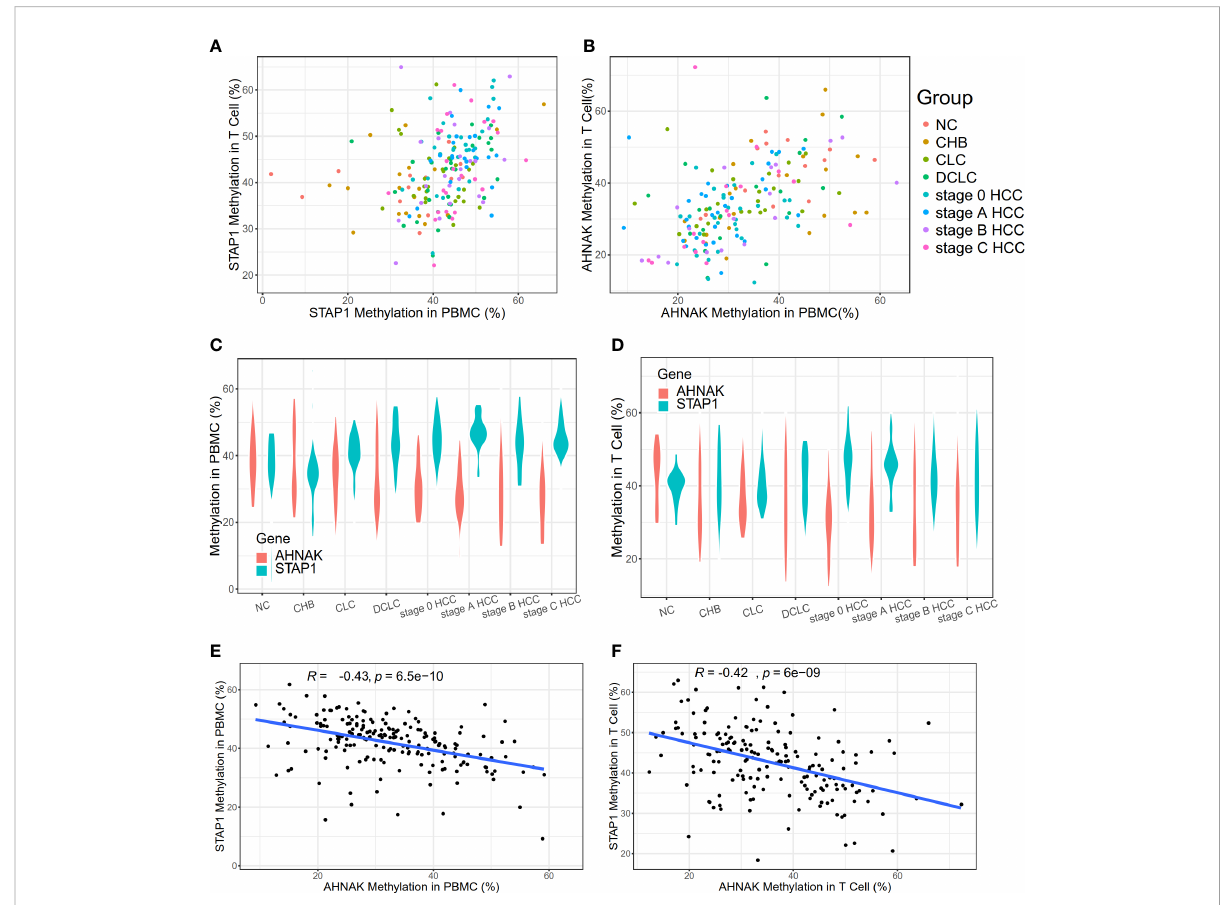
FIGURE 1 Methylation level of AHNAK and STAP1 in peripheral blood mononuclear cells (PBMC) and T cells in different liver diseases. (A) Methylation levels of STAP1 in PBMC and T cells. (B) Methylation levels of AHNAK in PBMC and T cells. (C) Methylation levels of AHNAK and STAP1 in PBMC at different disease stages. (D) Methylation level of AHNAK and STAP1 in T cells at different disease stages. (E, F) Negative correlation of methylation of AHNAK and STAP1 in PBMC and T